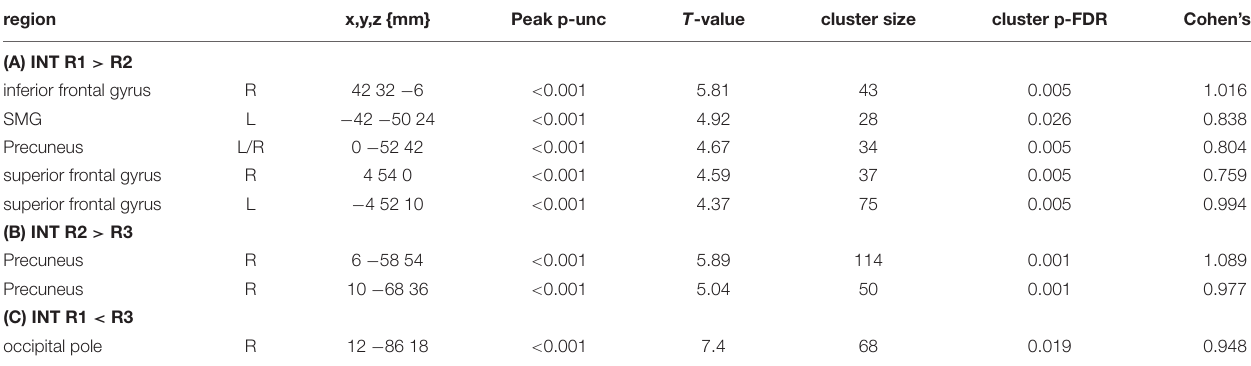
TABLE 4 | Effect of interference on consolidation-related resting-state activity. region